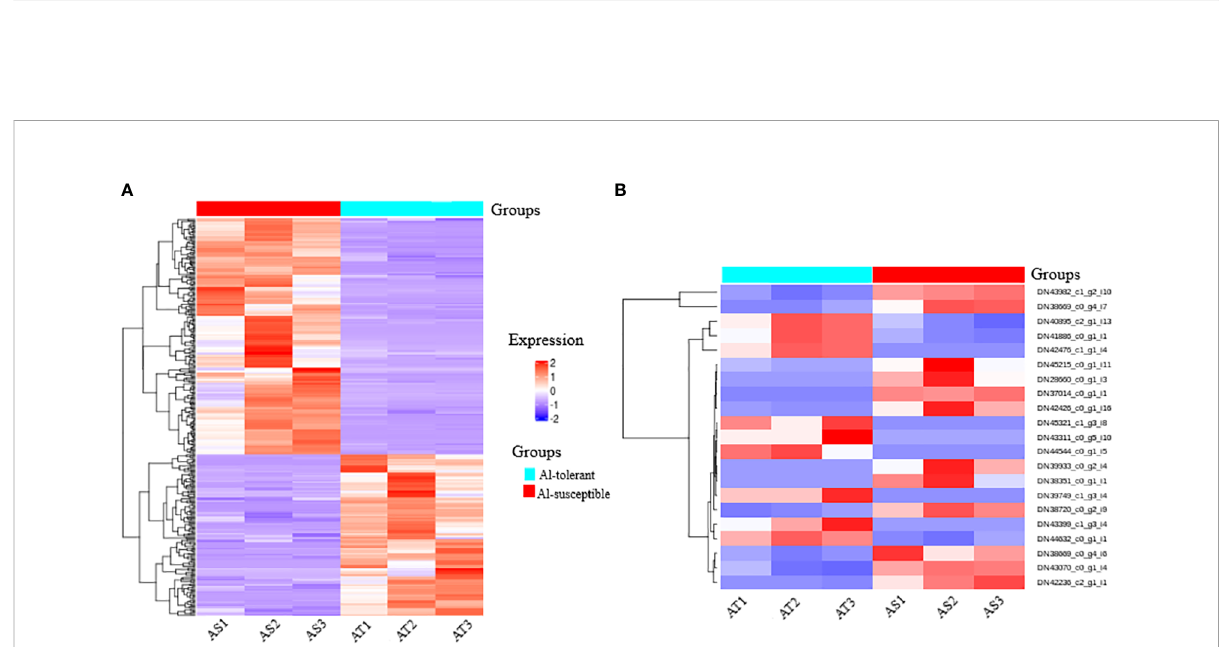
FIGURE 8 A heatmap map of two-way cluster analysis of (A) signi fi cantly differentially expressed genes among Al-tolerant and Al-susceptible fi nger millet genotypes and (B) selected unigenes that have association with Al-tolerance. Red shows higher gene expression, while blue shows lower gene expression. Genes are in row forming eight clusters (represented by different colors in a row just above the heatmap rows) based on the similarity in their expression patterns, whereas columns represent the two groups of genotypes and respective